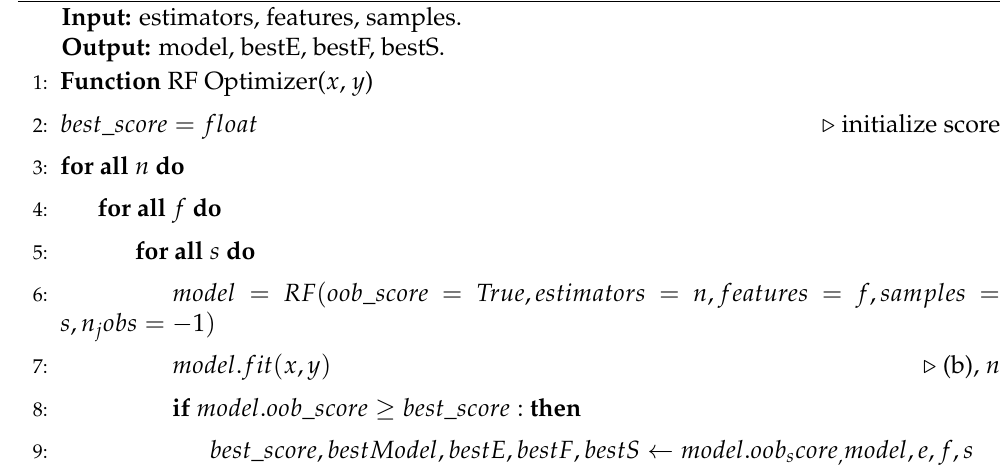
Algorithm 1 Stages of the proposed Random Forest Optimizer.